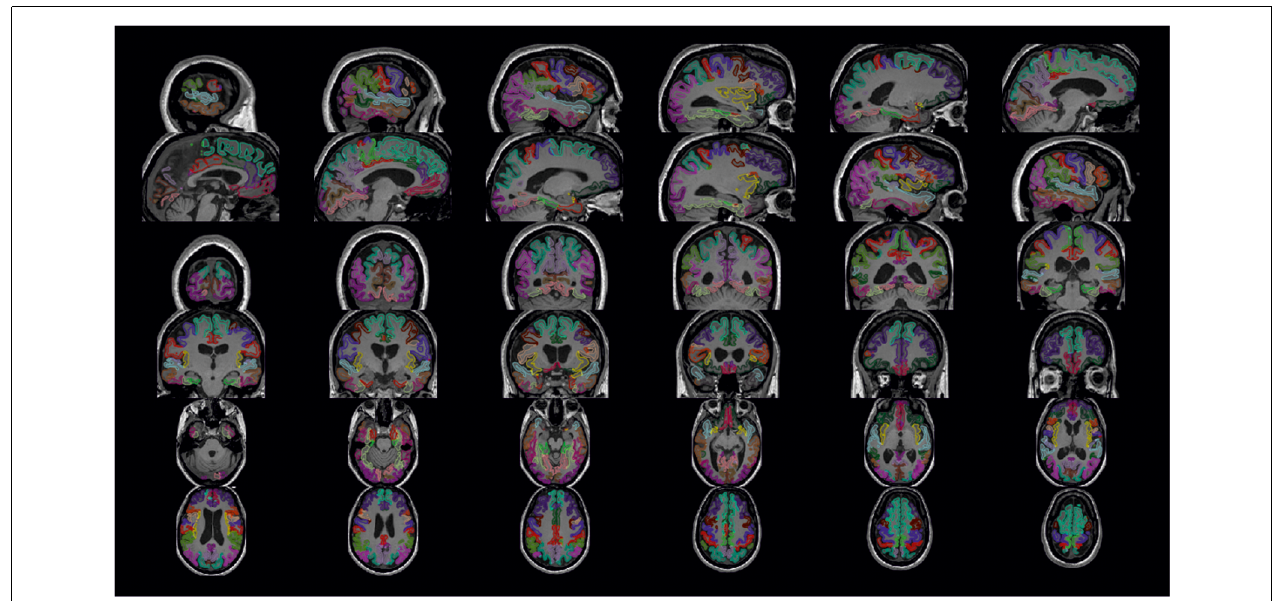
FIGURE 4 | Cortical parcellation quality control. Visualization is generated by the package visualqc with sagittal, coronal, and axial views of the resulting cortical parcellation.